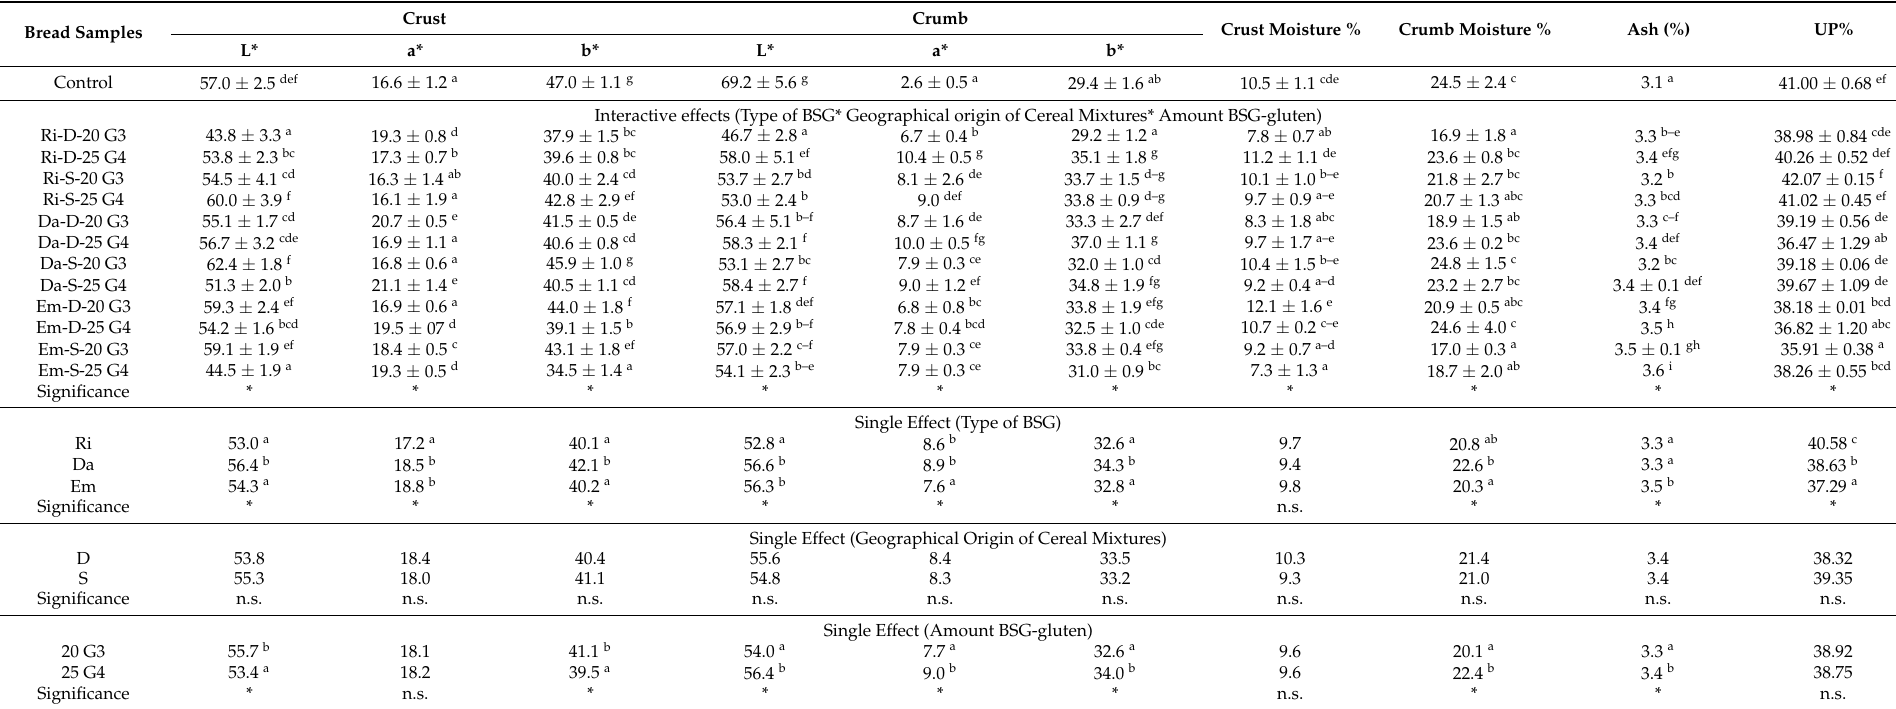
Table 5. Effects of type of BSG and amounts of BSG-gluten in the formulation on physical and chemical characteristics of the functional breads. Bread